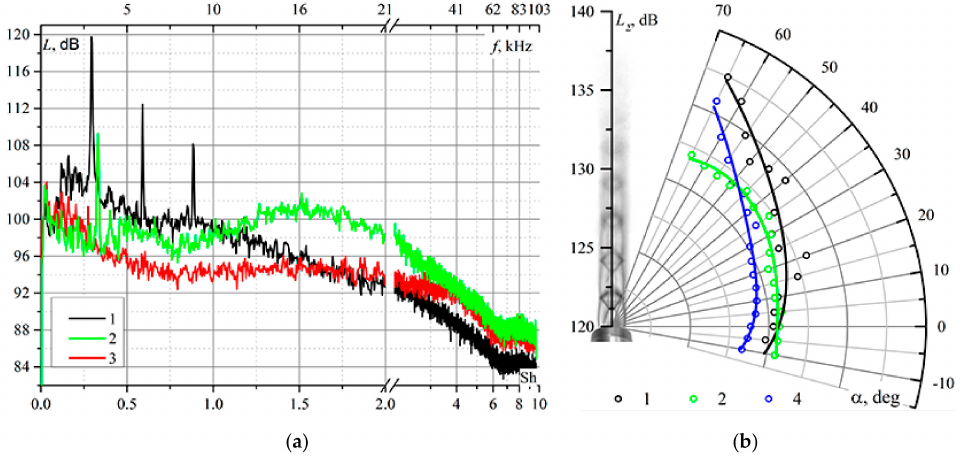
Figure 8. Impact of microjets and six installed chevrons on the spectrum of acoustic disturbances in the far acoustic field at α = 30 ◦ and r/R a = 80 ( a ) and on the noise pattern of the supersonic jet ( b ) [41]; 1—“clear” jet, 2—six chevrons, 3—six microjets N prj =9, 4—six microjets N prj =4 (N prj = P 0j /P c —nozzle pressure ratio for microjet, P 0j —total pressure in microjet).